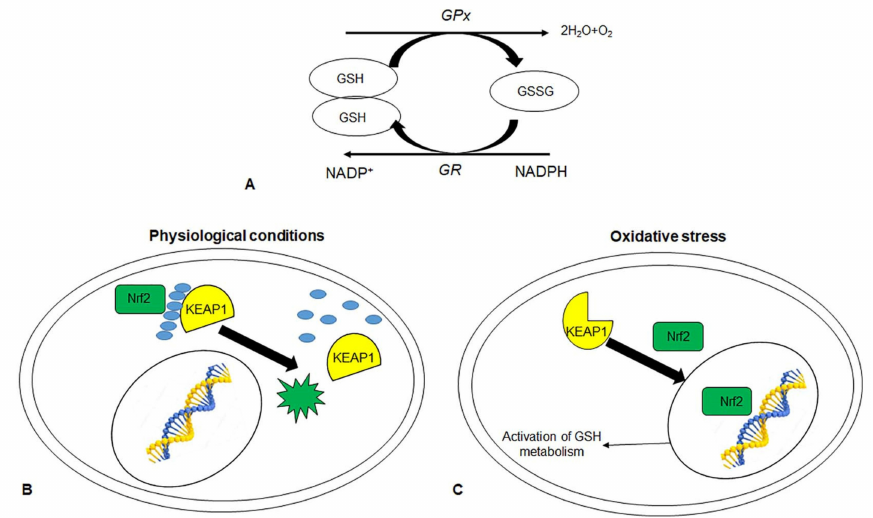
Figure 3. Schematic representation of Glutathione. ( A ) interconversion between the reduced (GSH) and oxidized (GSSG) form of Glutathione. The role of nuclear factor-2 related erythroid factor-2 (Nrf2) in GSH metabolism under physiological conditions ( B ) and oxidative stress ( C ). GSH: reduced glutathione; GSSG: oxidized glutathione; GPx: glutathione peroxidase; GR: Glutathione reductase; KEAP1: Kelch-Like ECH Associated Protein